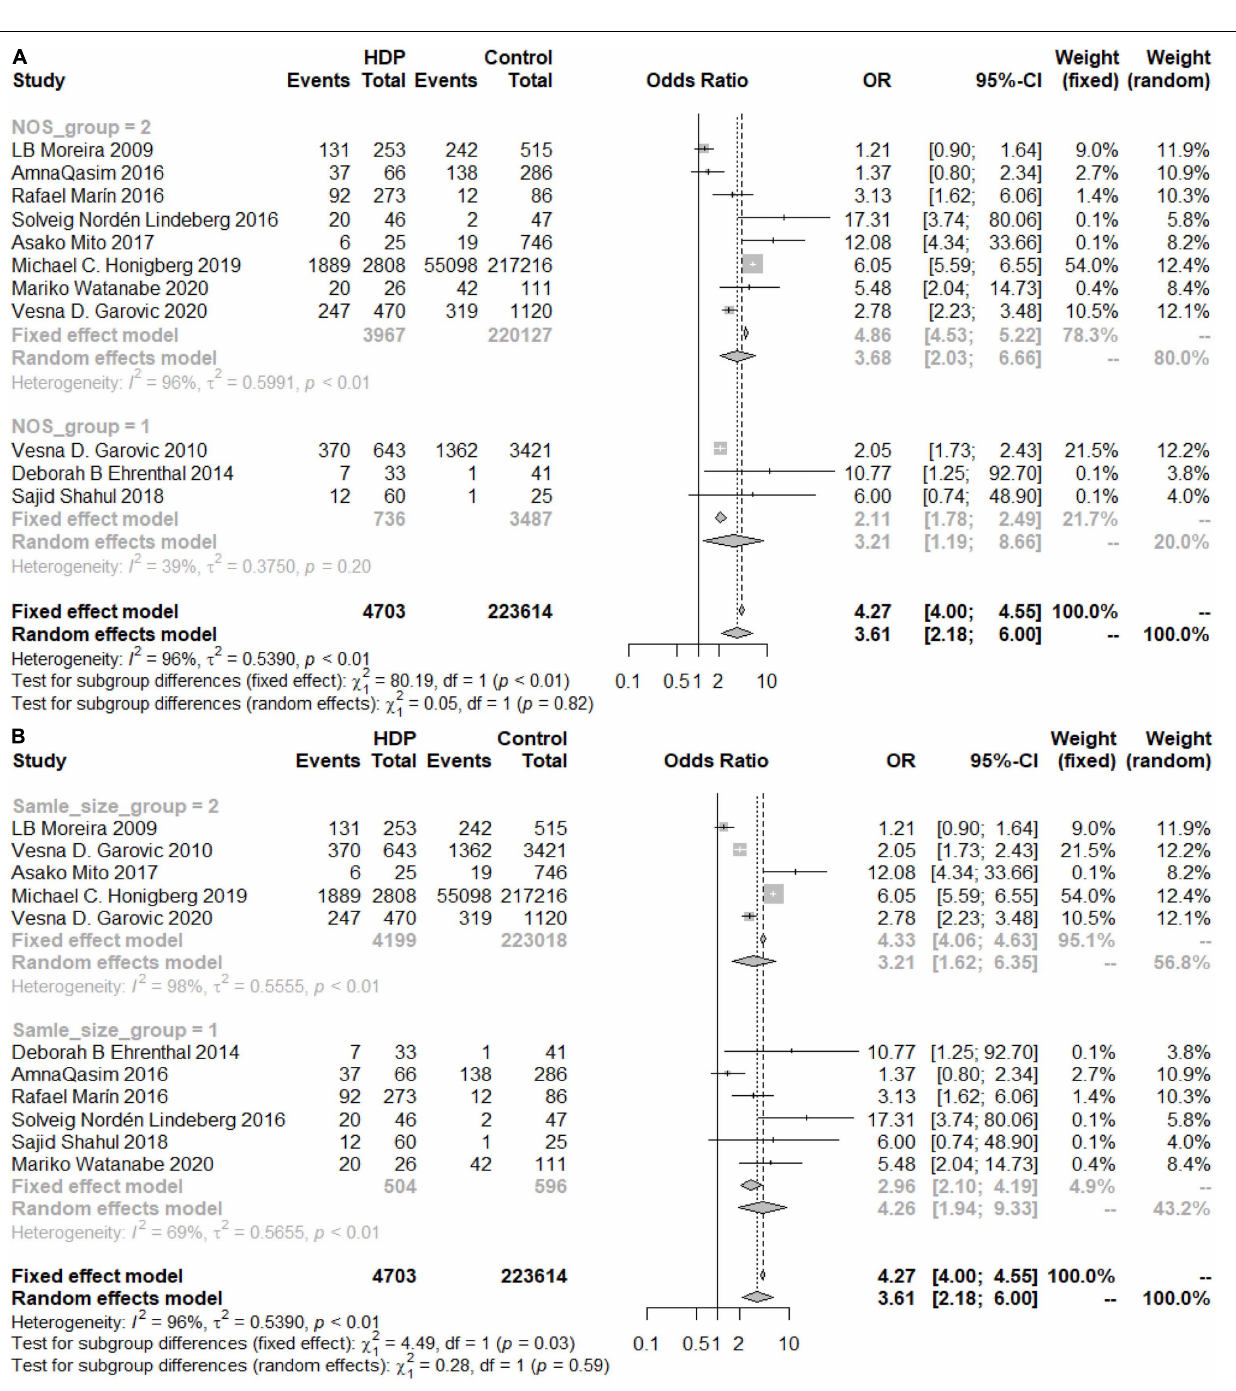
FIGURE 9 | (A) Subgroup analysis by NOS score of the risk of developing chronic hypertension in the HDP group (Group 1 = NOS < 7, Group 2 = NOS ≥ 7). (B) Subgroup analysis by the sample size of the risk of developing chronic hypertension in the HDP group (Group 1 = sample size < 500, Group 2 = sample size ≥